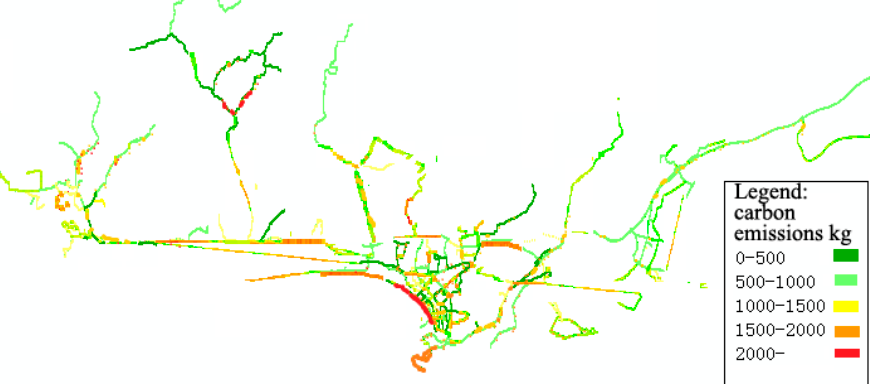
Figure 11. Spatial distribution of carbon emissions on buses lines in Sanya on rest days.